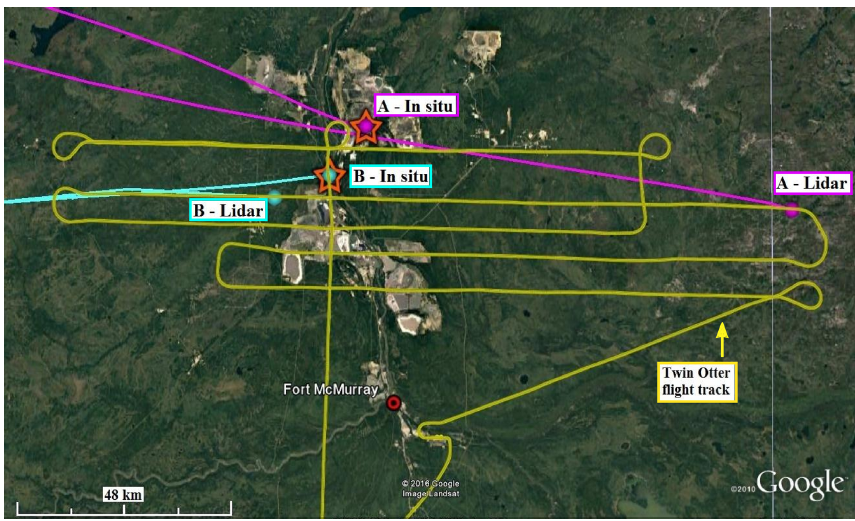
Figure 14. Flight tracks of the Twin Otter aircraft (yellow lines) and locations the Convair-580 aircraft spiral ascents for vertical profiles of in situ measurements (red stars). Backward trajectories coloured in blue and pink show the air coming from unpolluted and polluted areas respectively. Points labelled as A and B correspond to cases (a) and (b) in Fig.